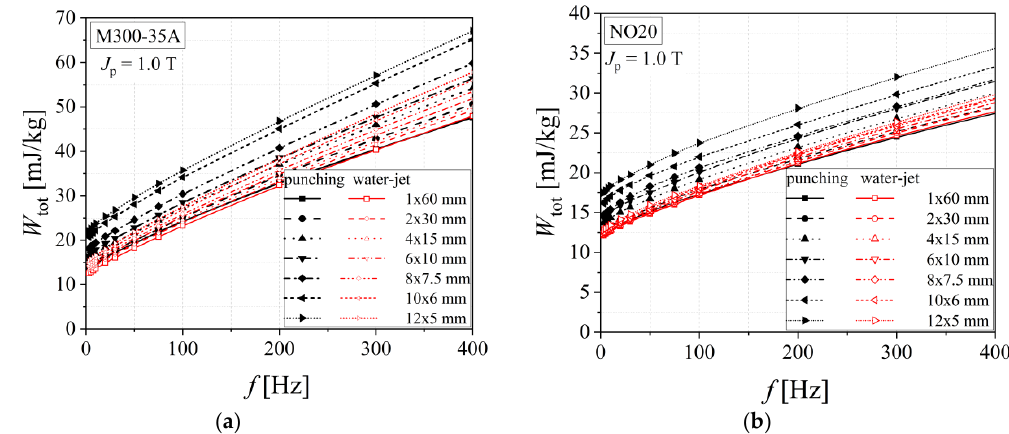
Figure 11. Total energy loss versus frequency dependencies of electrical steel grade M400-65A ( a ) and M400-50A ( b ), in the case of two cutting technologies.